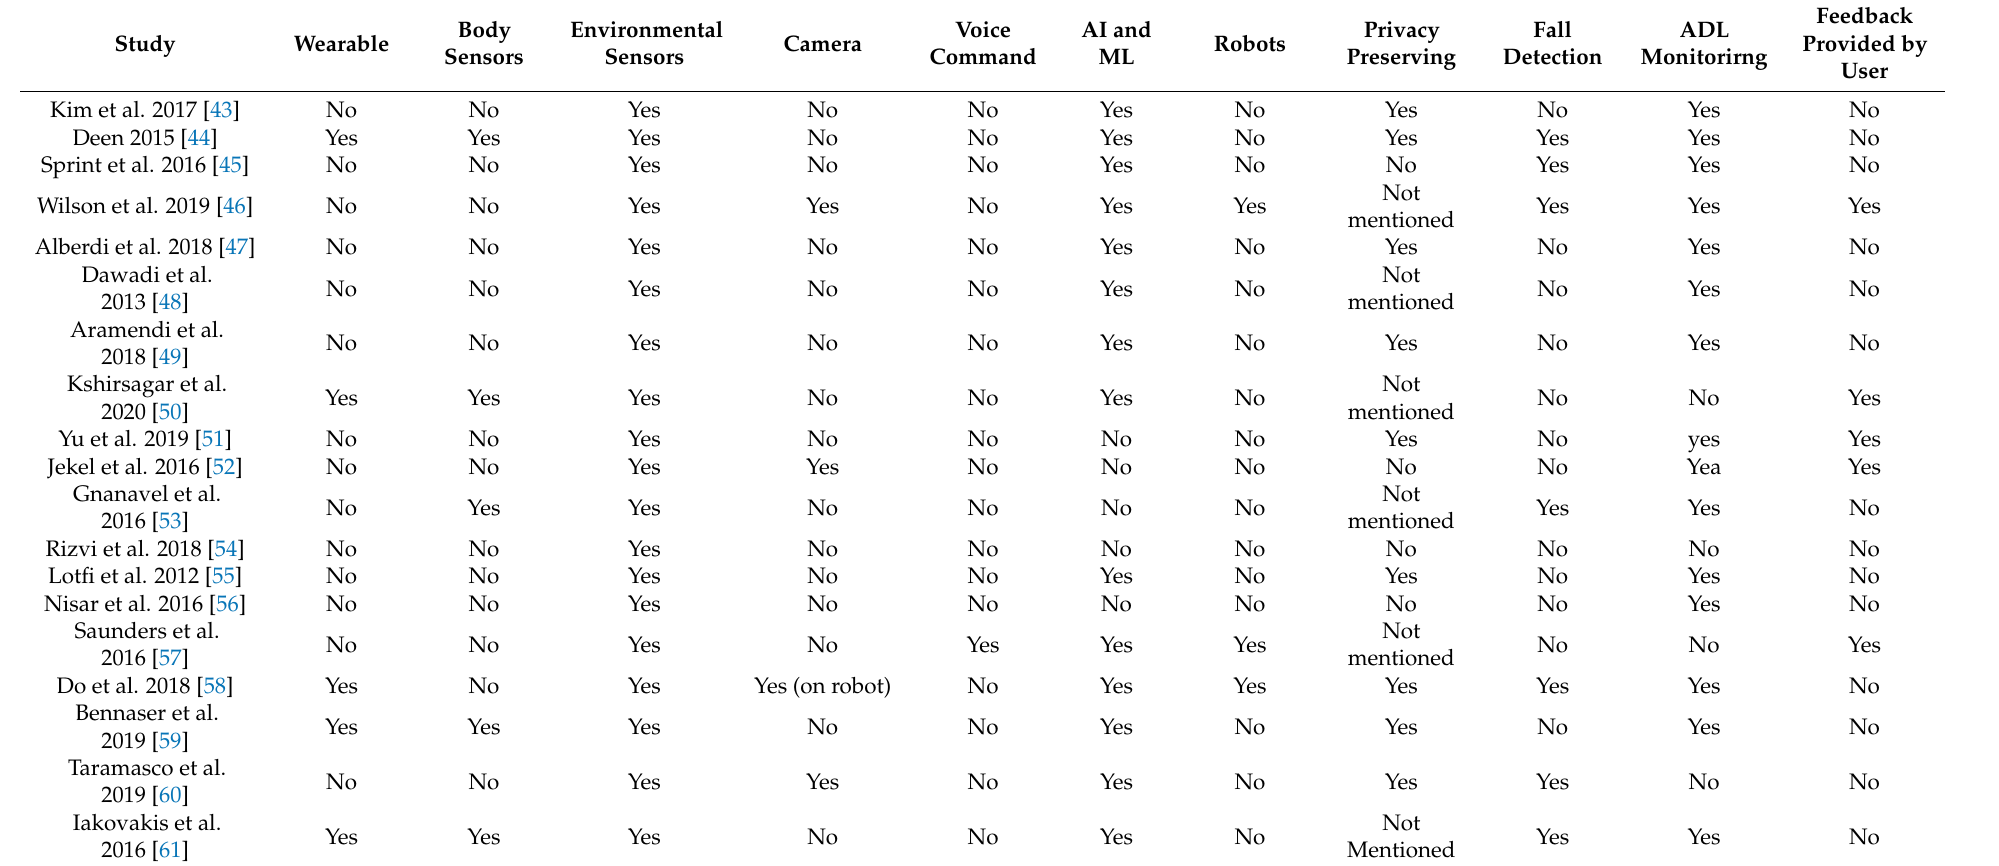
Table 2. Features of smart home